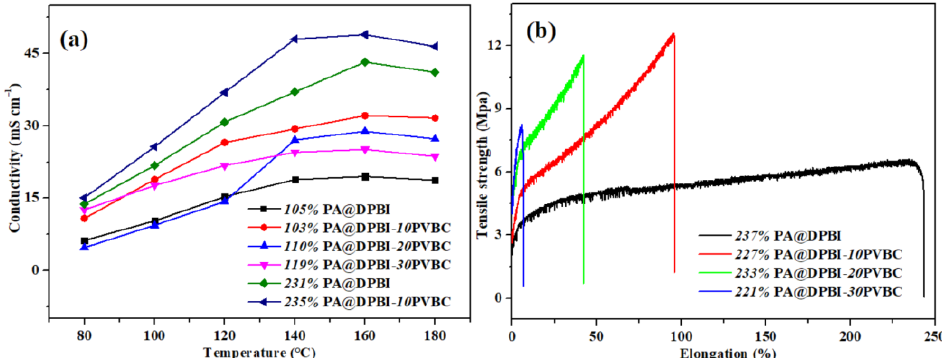
Figure 3. ( a ) Proton conductivities and ( b ) stress-strain curves of PA doped membranes. Table 2. PA uptake, and mechanical properties of PA doped DPBI- x PVBC membranes.